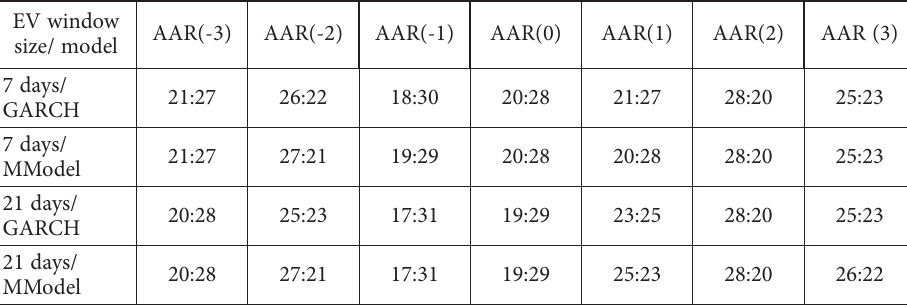
Table 3. Results of the robustness checks (source: own design) EV window size/